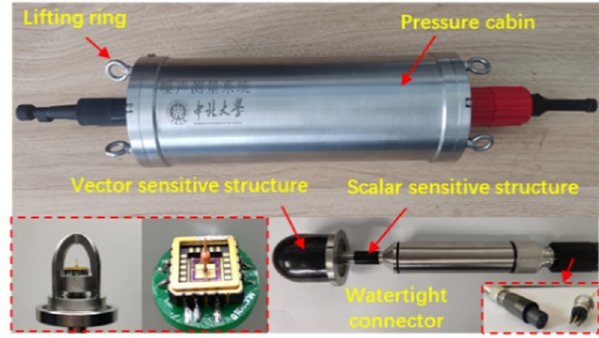
Figure 3. Overall structure diagram.